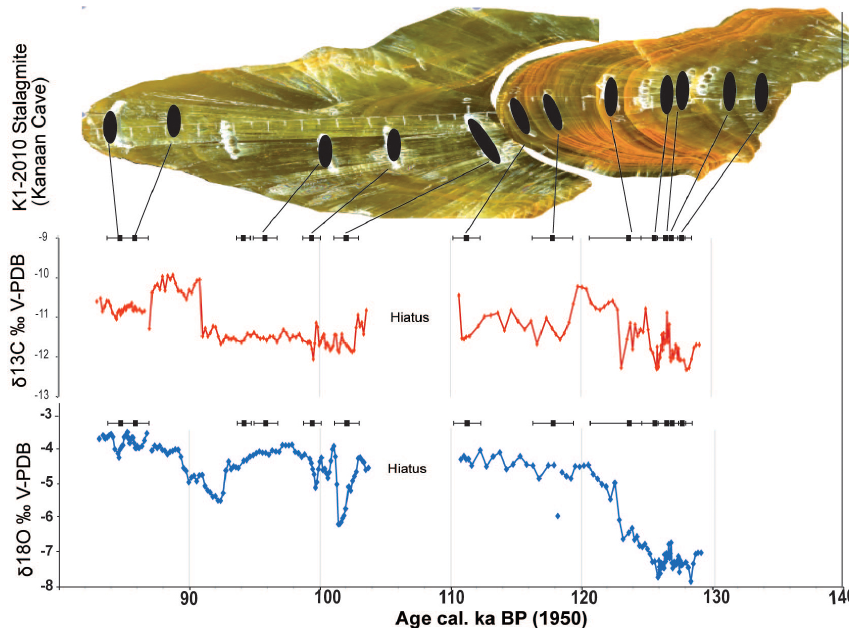
Figure 5. δ 18 O and δ 13 C profiles (values are in ‰ VPDB) of samples microdrilled along the growth axis of the K1-2010 stalagmite (Kanaan Cave,